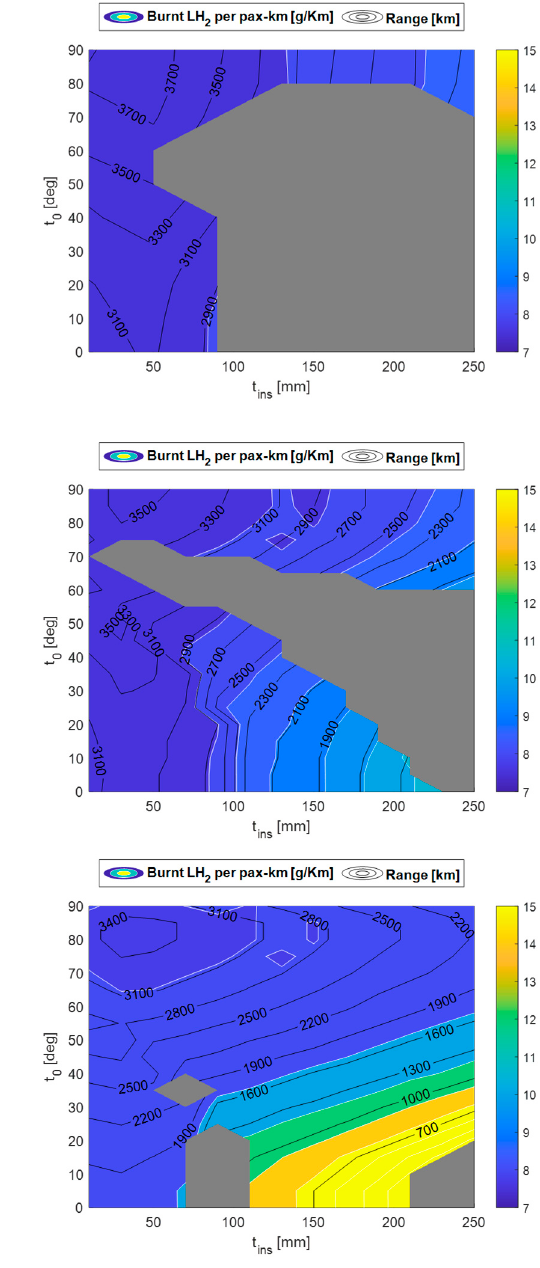
Figure 19. Sensitivity of number of tanks (left) and burnt LH 2 per pax-km (right) to t 0 and t ins , with range indication: ( a ) without R min constraint; ( b ) with R min = 0.5 m; ( c ) with R min = 0.5 m and catwalk width = 0.8 m.